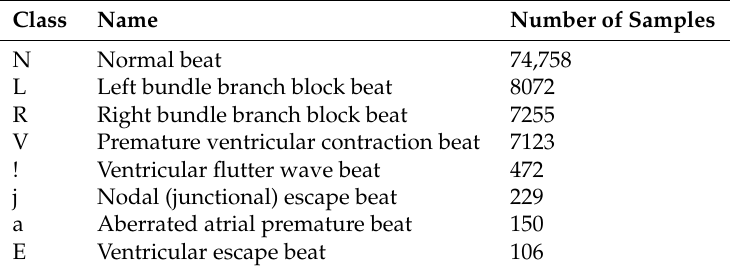
Table 1. Classes selected of MIT-BIH Arrhythmia Database.